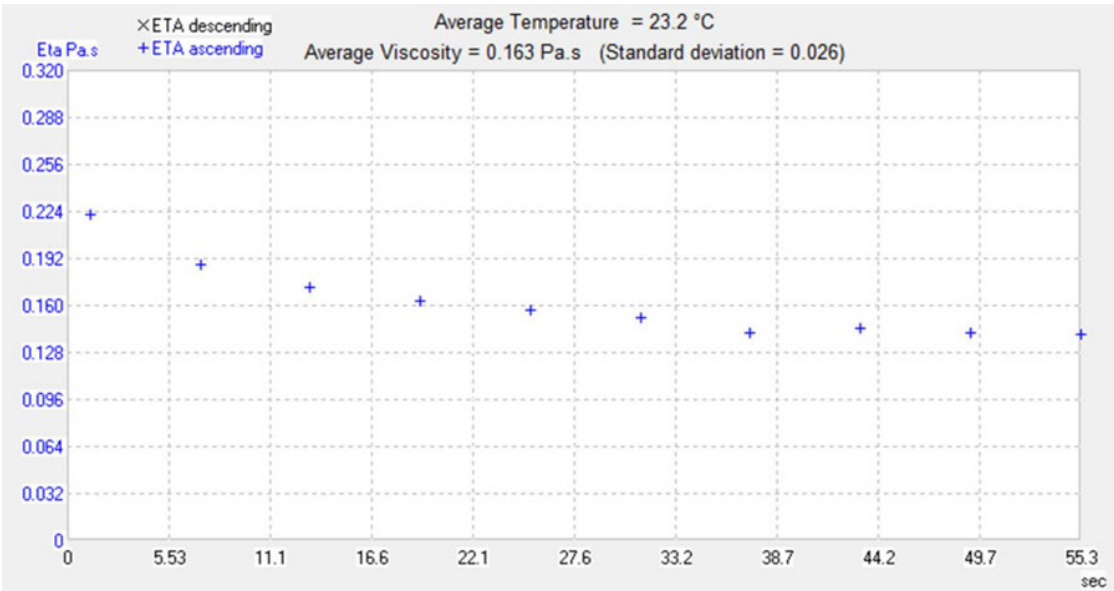
Figure 10. Rheological study. The rheogram showing flow behavior of the formulation.